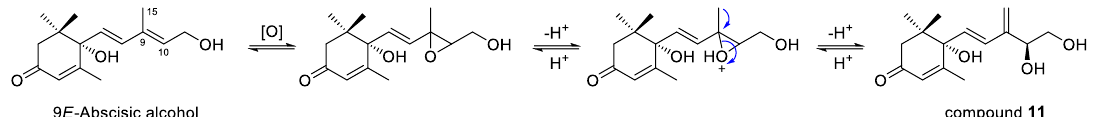
Figure 6. Possible biogenetic pathway of compound 11.